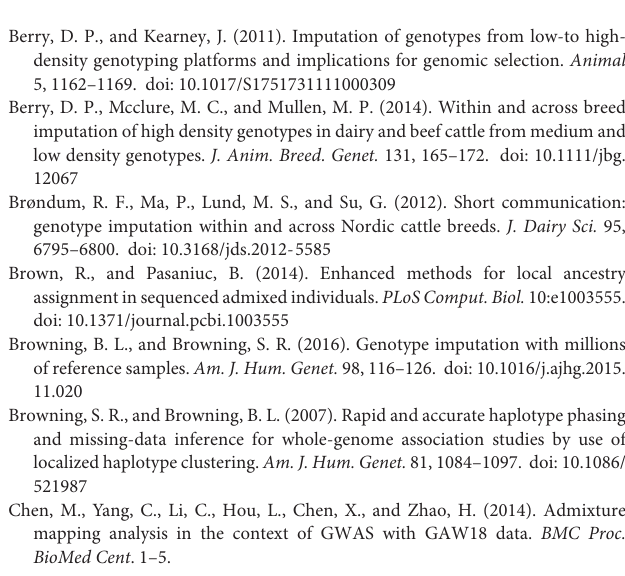
Supplementary Figure S1 | Ancestral origin heterozygosity against European breed proportion of crossbred animals using LAMP-LD based on (A) two-way admixture and (B) three-way admixture, showing the number of animals clustered at a particular location. Note that the clustering algorithm causes exaggerated shifts of the centroid of each point on the plot compared to Figures 4B , 5B . Supplementary Figure S2 | Individual heterozygosity in West African crossbred cattle plotted against European breed proportion estimated using two-way admixture using (A) ADMIXTURE and (B) LAMP-LD. Supplementary Figure S3 | The value of correlation and concordance of imputed SNPs against the MAF for the 2F_LD-MD